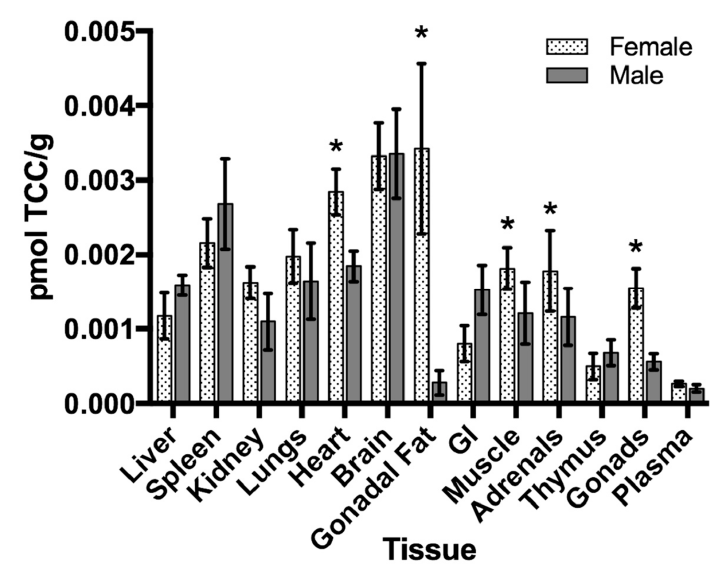
Figure 6. Tissue distribution of 14C-TCC in exposed o ff spring at postnatal day 42. Data is expressed as pmol of TCC / gram of tissue ± SEM ( n = 5 / sex). * p < 0.05, when comparing female to male o ff